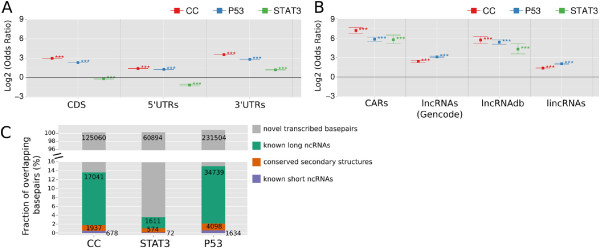
DE-TAR overlap with genomic annotation.(A,B) Overlaps in nucleotides between DE-TARs and different annotation categories. Log2 transformed odds ratios and their 95% confidence interval for the respective annotation dataset are shown (annotations are described in detail in Additional file 1: Table S28). To assess the significance of the observed overlap, 100 lists containing random intervals from the genome controlling for repeat content and DE-TAR length were sampled. Odds ratios of observed versus randomized relative overlaps were calculated and tested using Fisher’s exact test for significant enrichment or depletion. *** indicates P<0.001 for the observed versus random nucleotide overlaps, ** P<0.01 and * P<0.05. Results are shown for DE-TARs that overlap annotated protein-coding genes (A) (additional annotations are shown in Additional file 1: Figure S10) and bona fide non-coding DE-TARs that overlap with several classes of experimentally verified and predicted ncRNAs (B) (additional annotations shown in Additional file 1: Figure S11). For the detailed output of Fisher’s exact tests refer to Additional file 1: Tables S4 and S6. (C) Fraction of nucleotides in intergenic bona fide non-coding DE-TARs overlapping with known long ncRNAs (large intergenic non-coding RNAs and transcripts of unknown protein-coding potential as identified in [30], Gencode v12 long ncRNAs, lncRNAs found in the Long Non-Coding RNA Database (lncRNAdb, [49]) and ncRNAs found in chromatin [50]), short RNAs (UCSC sno/miRNA track), conserved secondary structures (Evofold[45], RNAz[44,51] and SISSIz[52]) and novel transcribed nucleotides. CAR, chromatin-associated RNA; CC, cell cycle; CDS, coding sequence; lncRNA, long ncRNA; ncRNA, non-protein-coding RNA; UTR, untranslated region.